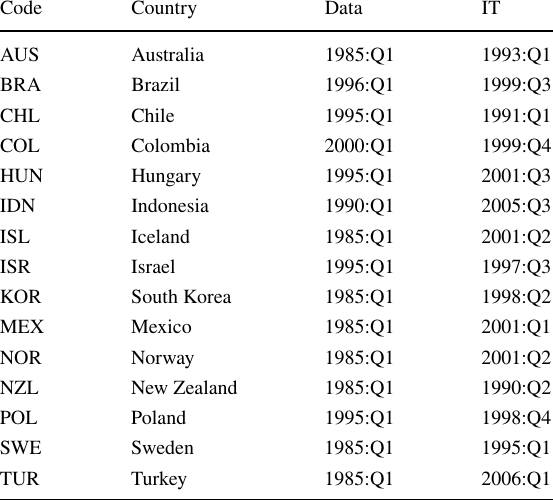
Table 6 List of countries and data availability. Source : Own